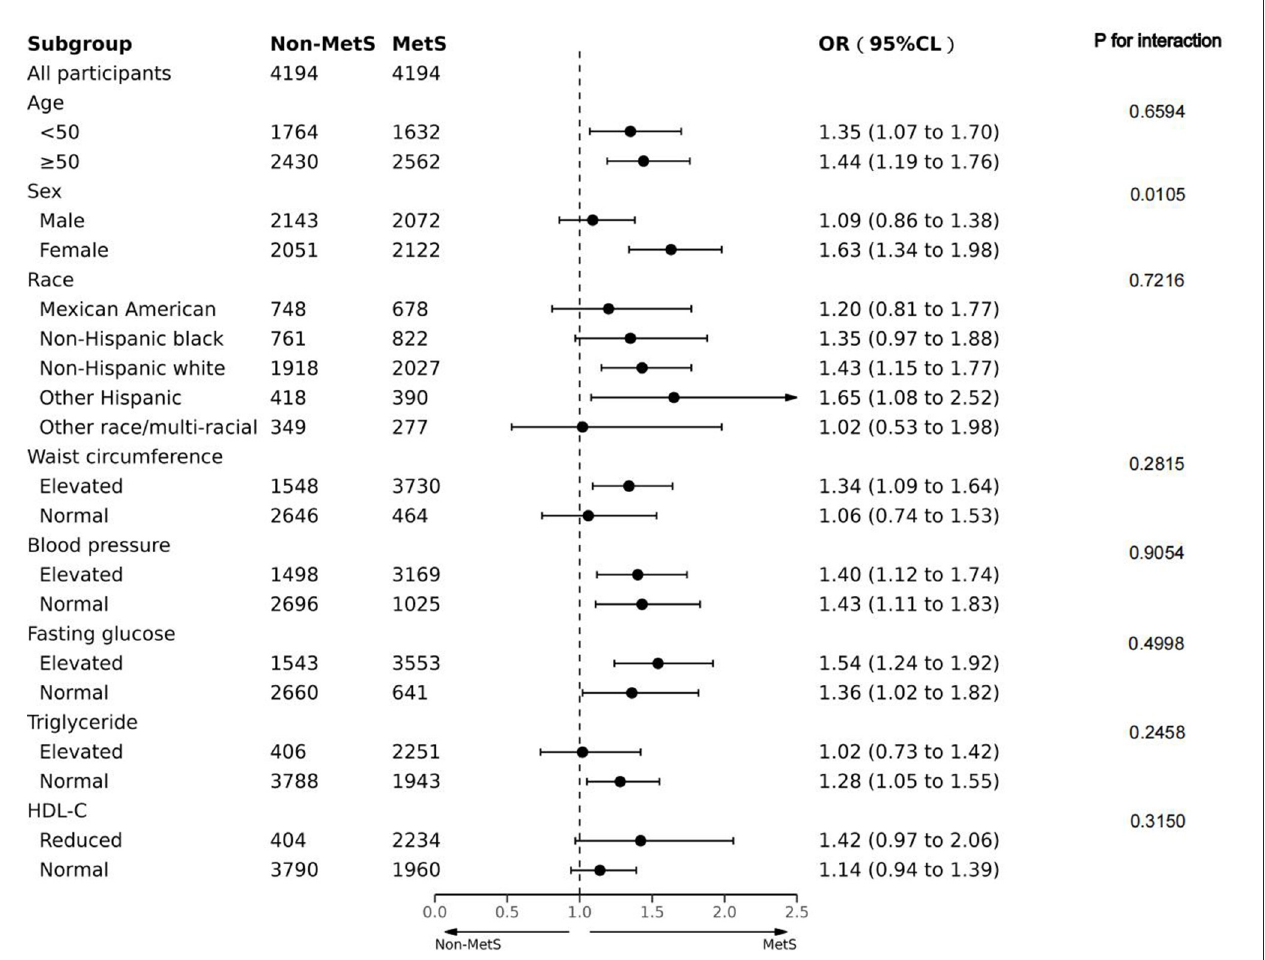
FIGURE3 Forest plot of the association between MetS and depression in terms of age, sex, race, and components associated with MetS in the PS-matched cohort. Adjusted for PS.